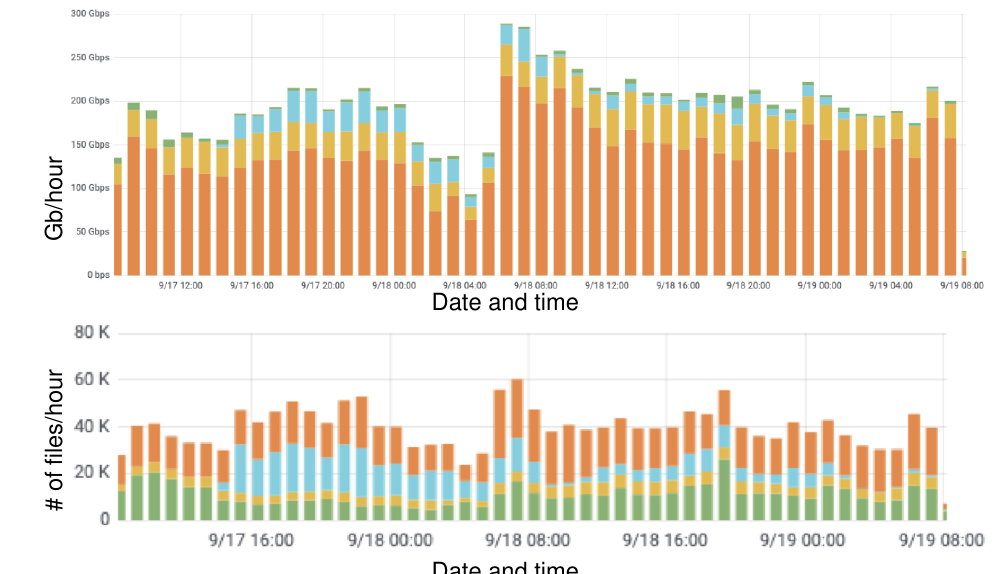
Figure 2. The top plot shows the volume of data transferred with PhEDEx (orange and yellow), Rucio (blue), and by users (green) during the “Million File Test.” The lower plot shows the number of files transferred in the same categories during the same time period. The number of files transferred by Rucio and PhEDEx during the test was